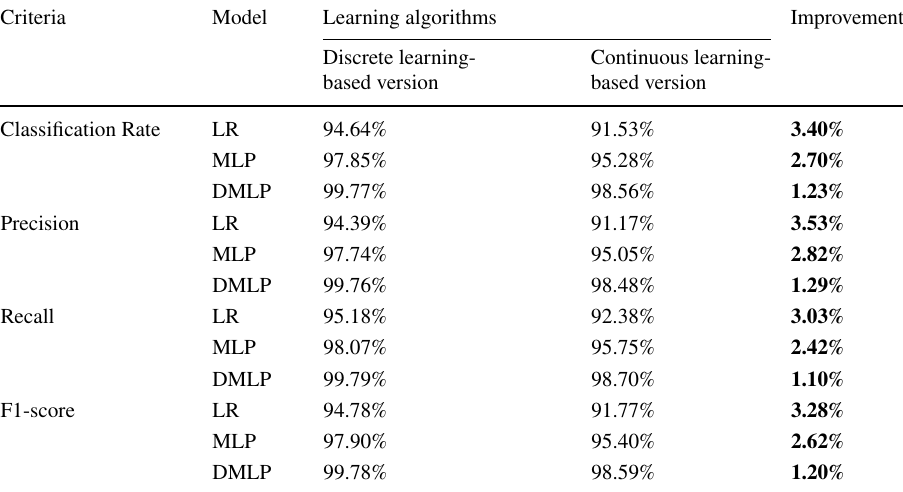
Bold values indicates the average and